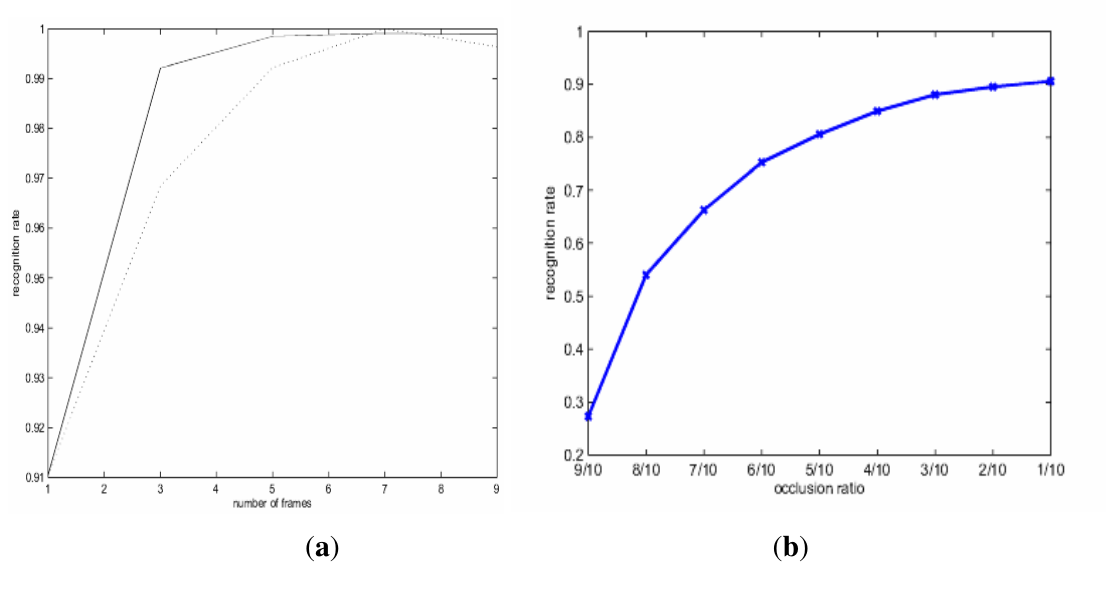
Figure 5. The recognition performance of sparse coding-based recognition: ( a ) exploiting temporal redundancy improves the recognition accuracy (solid: sum rule; dashed: majority voting); ( b ) the recognition performance gracefully degrades as the occlusion ratio increases (no temporal fusion involved l = 1